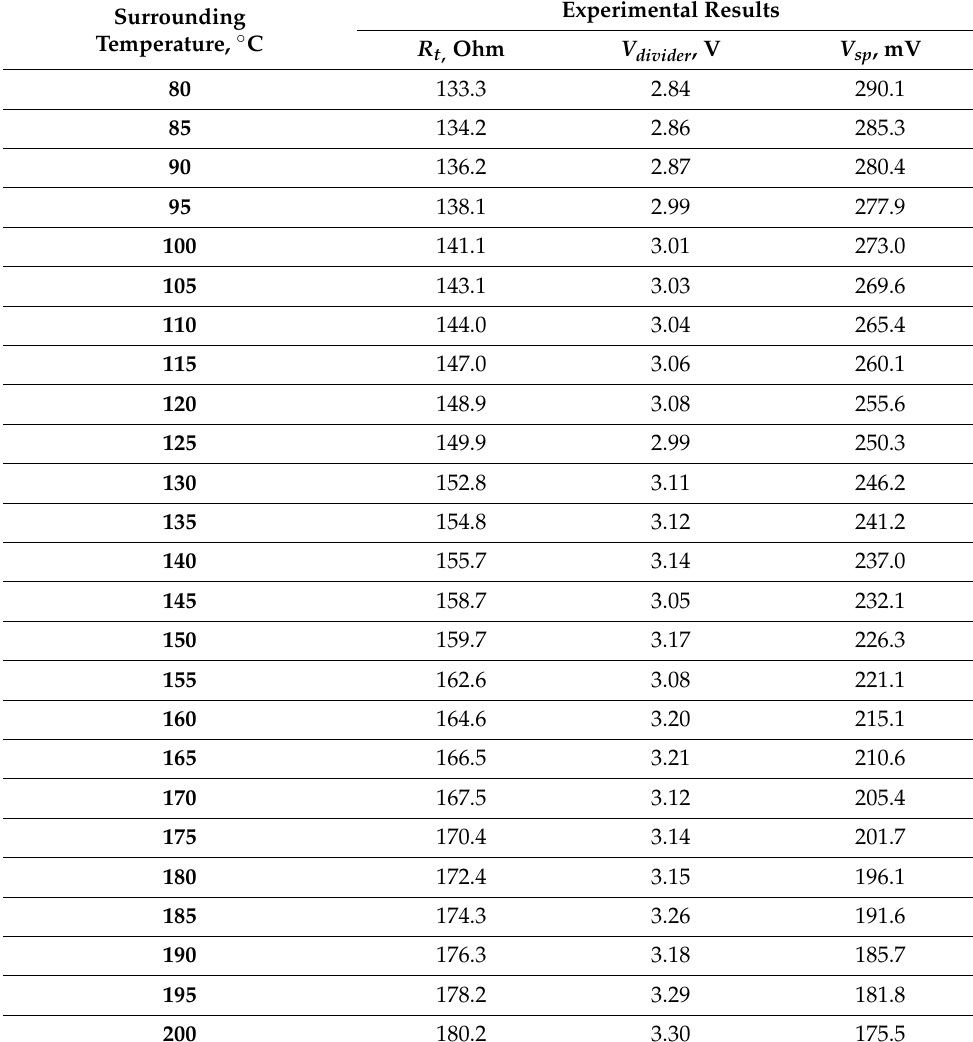
Table 1. Cont. Surrounding Temperature, ◦